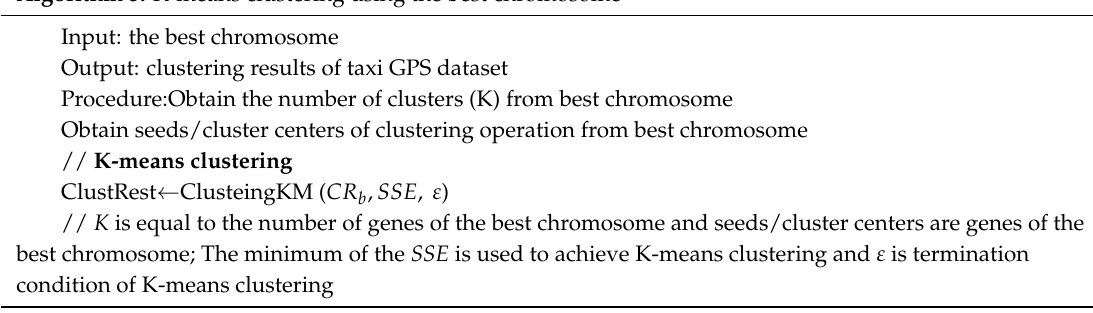
Algorithm 5. K-means clustering using the best